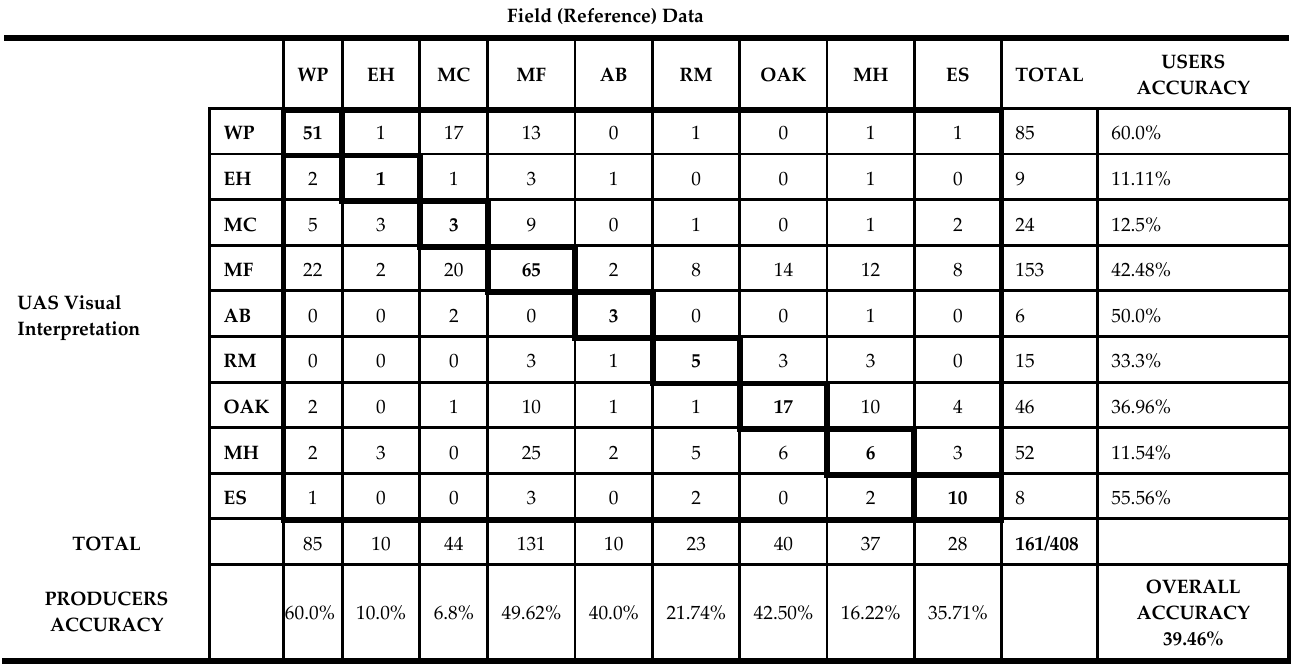
Table 2. Plot-level forest composition thematic accuracy for UAS visual interpretations of nine classes.